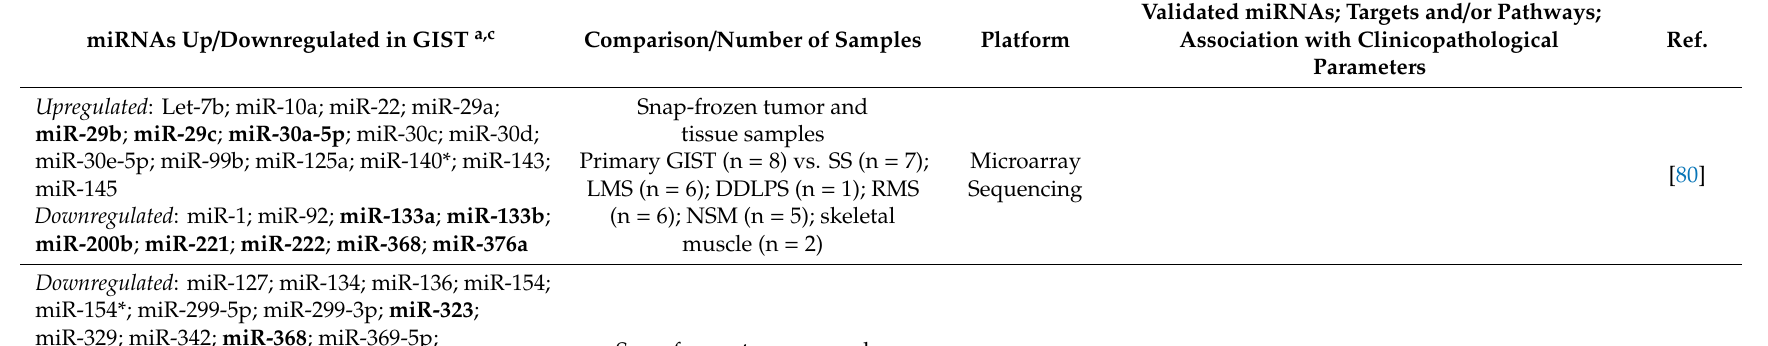
Table 1. Dysregulated microRNAs (miRNAs) in Gastrointestinal Stromal Tumors.